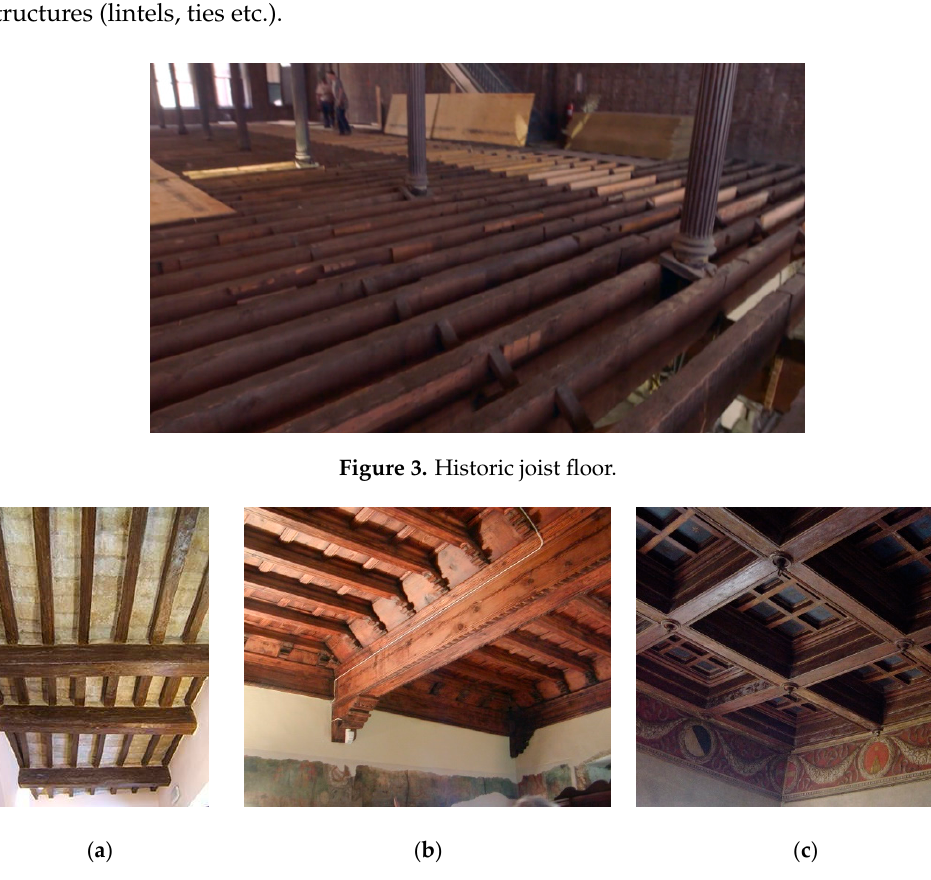
Figure 4. Different types of horizontal diaphragms (floors): ( a ) common timber-beam floor (solid beams and rafters, tiles); ( b ) decorated and carved timber timber-beam floor; ( c ) bi-directional timber-beam